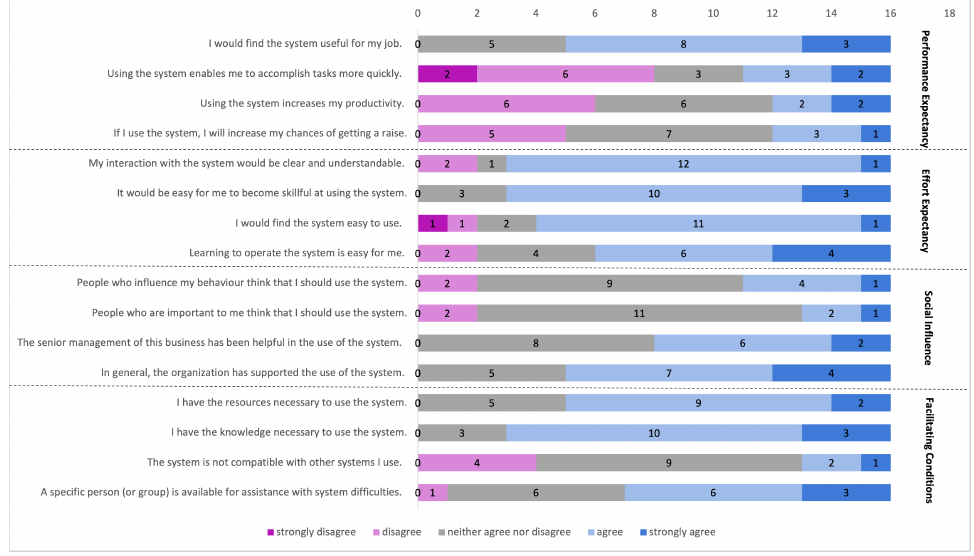
Figure 15. The UTAUT questionnaire results for the correlation analysis of multivariate data use case. Each coloured section indicates the number of participants who responded between ‘strongly disagree’ and ‘strongly agree’ (i.e.,